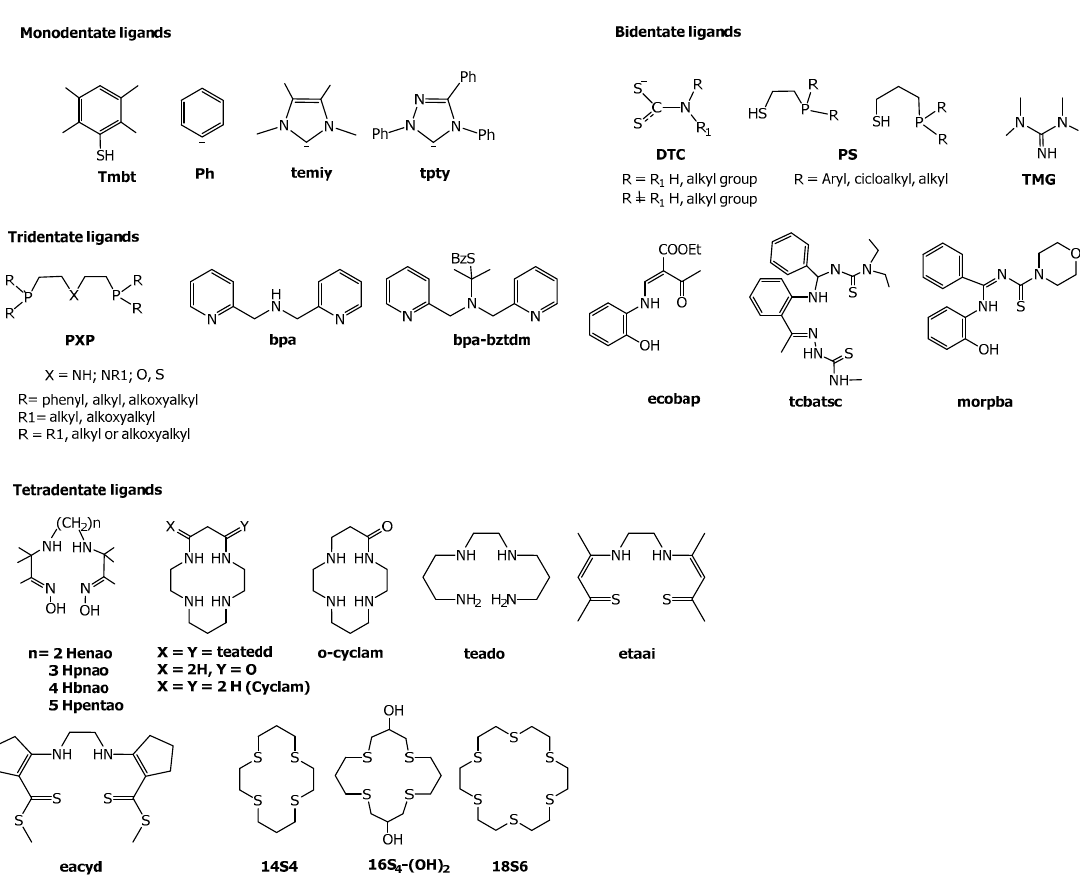
Figure 1. Schematic drawings of a selection of the ligands reported in Tables 1–3. For the complete chemical names see list of abbreviations.